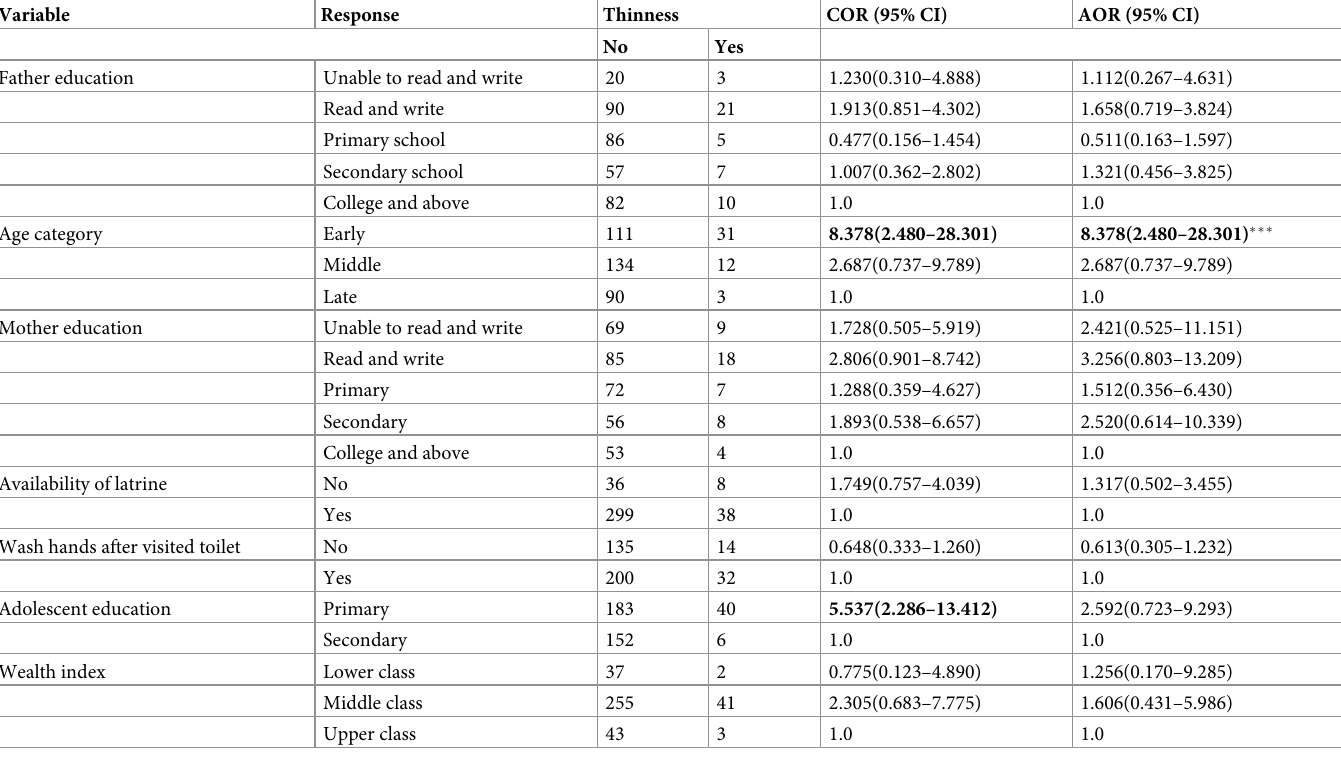
Table 7. Bivariable and multivariable logistic regression of factors associated with thinness among urban school adolescent girls, 2020 (n = 381).